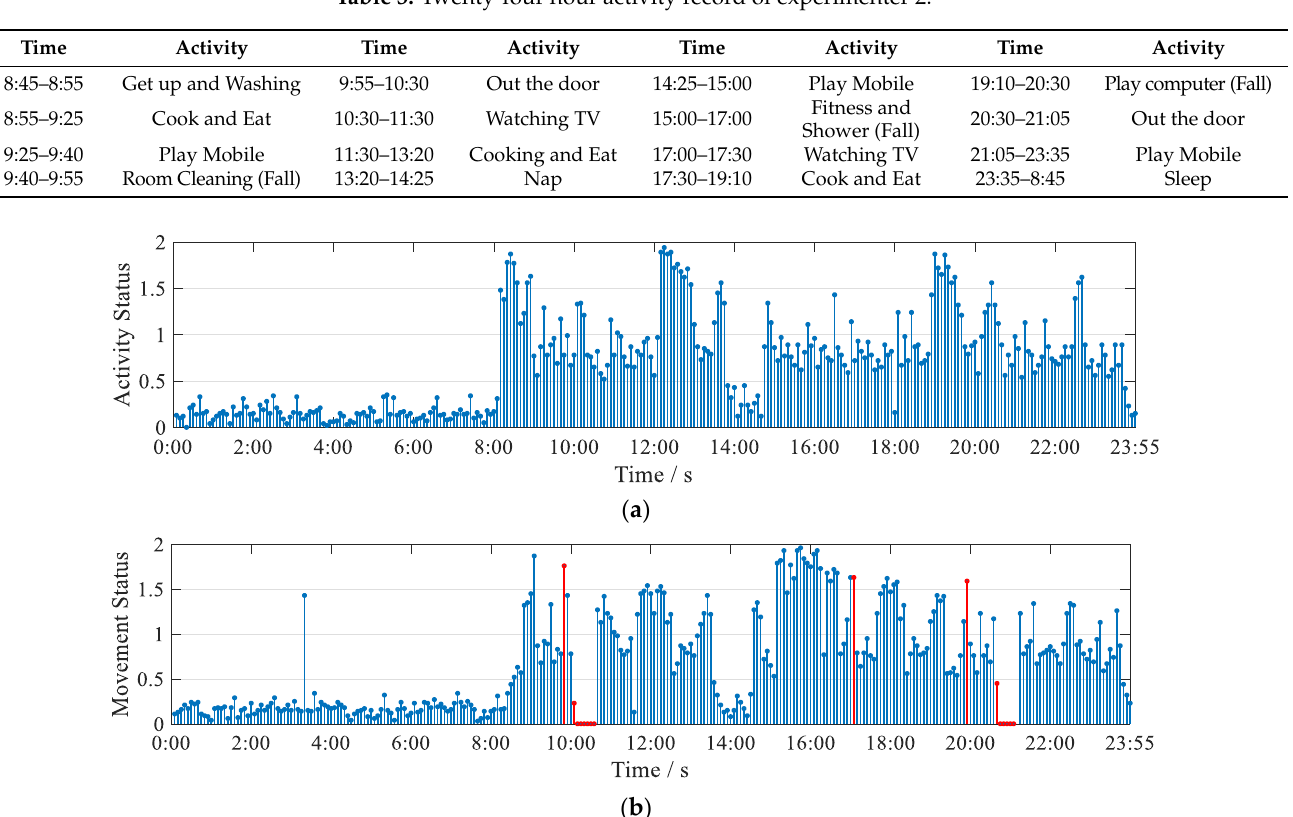
Table 3. Twenty-four hour activity record of experimenter 2.